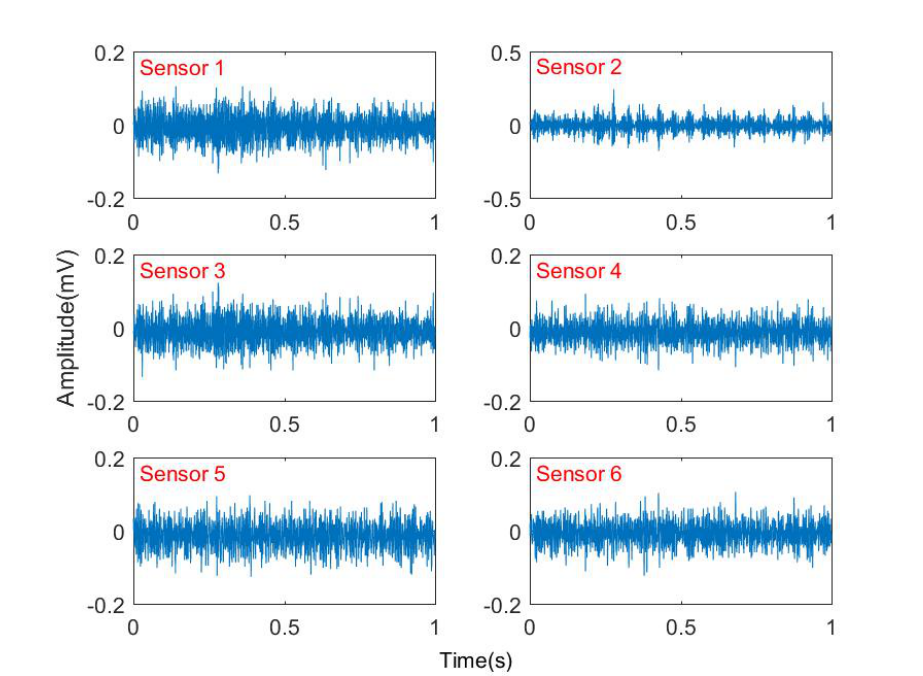
Figure 5. Waves of vibration signals under normal condition.